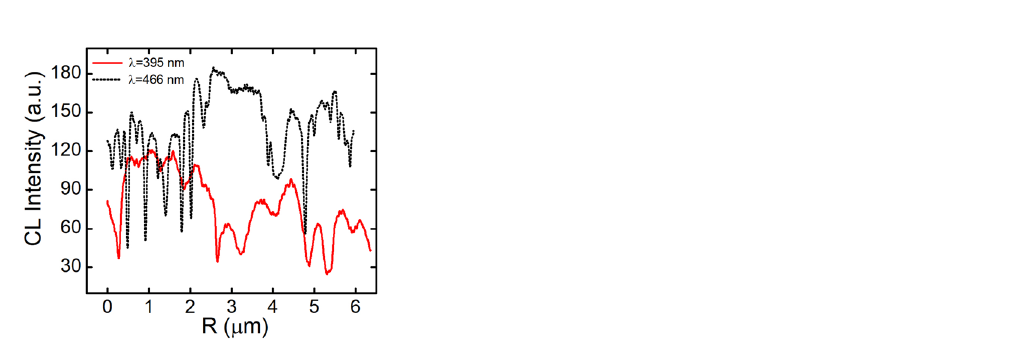
Figure 7. Cathodoluminescence intensity as a function of position for QWs emitting at λ = 395 nm and λ = 466 nm.